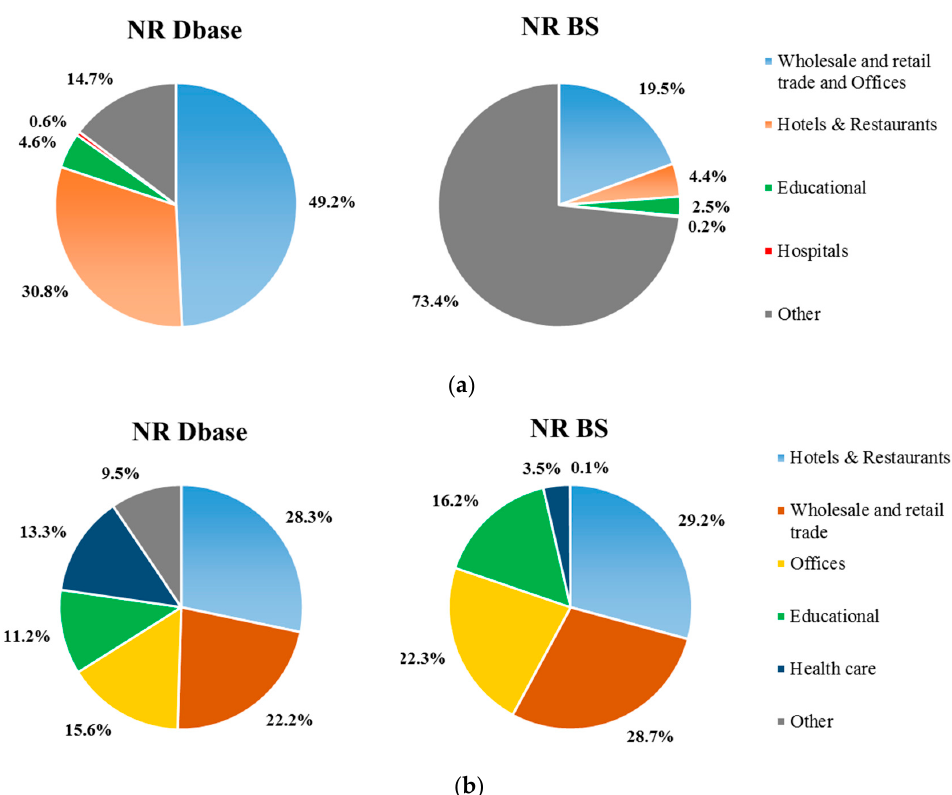
Figure 3. Distribution of ( a ) number of buildings and ( b ) total floor area of buildings in the nonresidential database from the certificates (NR Dbase) and the national building stock data (NR BS).